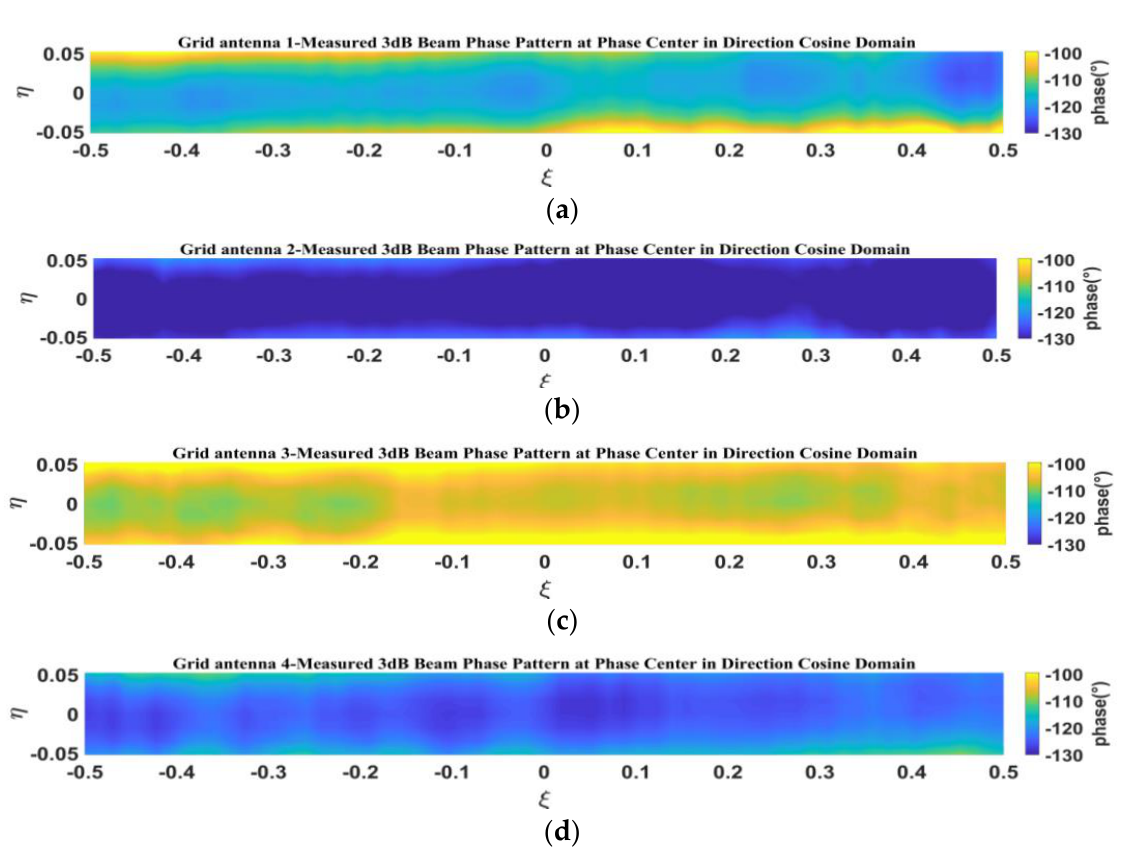
Figure 27. Measured phase pattern of 3-dB beamwidth at the phase center in direction cosine domain: ( a ) grid antenna 1; ( b ) grid antenna 2; ( c ) grid antenna 3; ( d ) grid antenna 4.